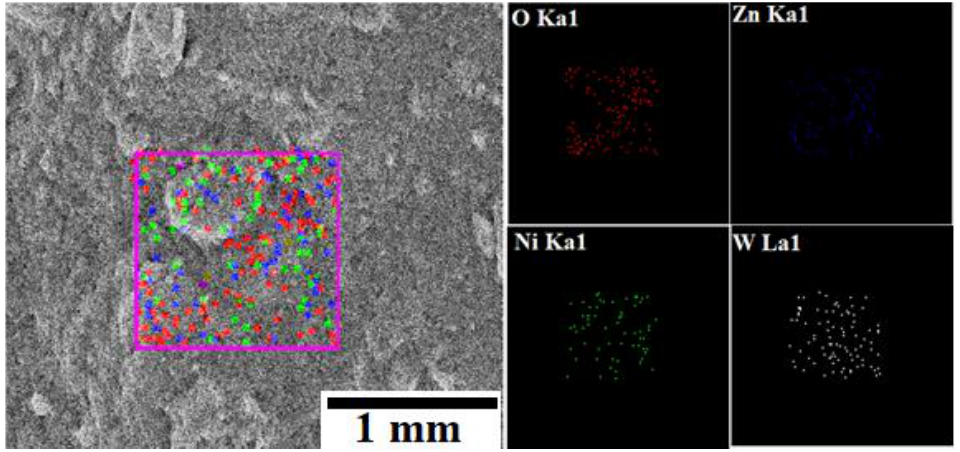
Nanomaterials 2023 , 13 , x FOR PEER REVIEW Figure 3. FESEM image of ( A ) ZnWO 4, ( B ) NiWO 4, ( C ) ZnNiWO 4, and ( D ) EDX spectra of ZnNiWO 4 Figure 3. FESEM image of ( A ) ZnWO 4 , ( B ) NiWO 4 , ( C ) ZnNiWO 4 , and ( D ) EDX spectra of ZnNiWO 4 .